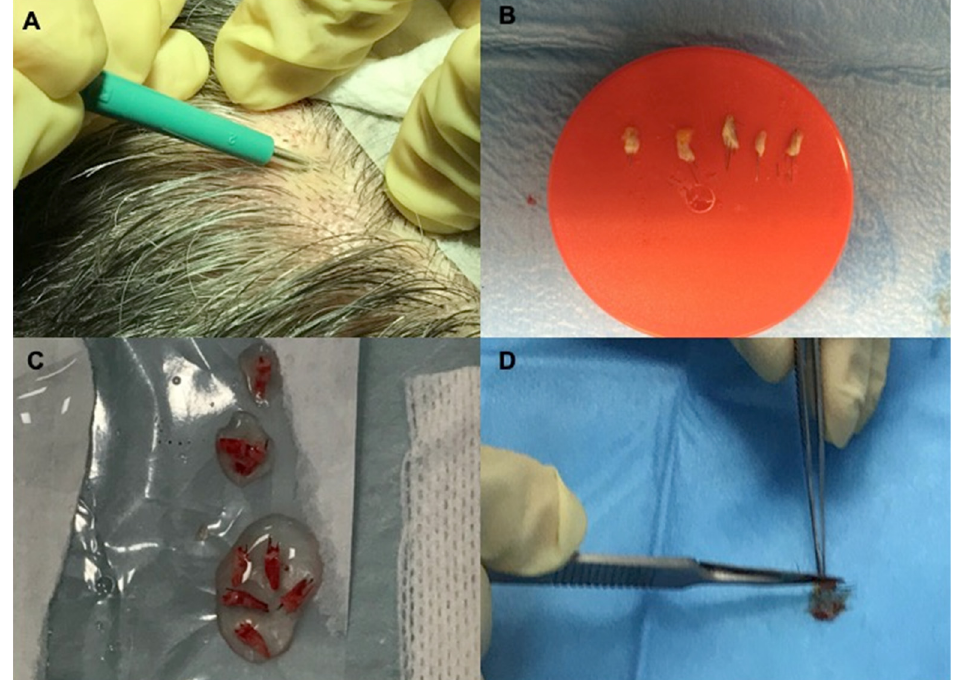
Figure 6. Micro-grafts preparation. Step 1 (Punch biopsy harvesting and fragments selection) ( A ) punch biopsy (2 mm of diameter), ( B ) fragments selections containing intact bulb and bulge area, ( C ) fragments stored in saline solution, ( D ) splitting of the scalp tissues harvested into the strips (2.0 × 2.0 mm).